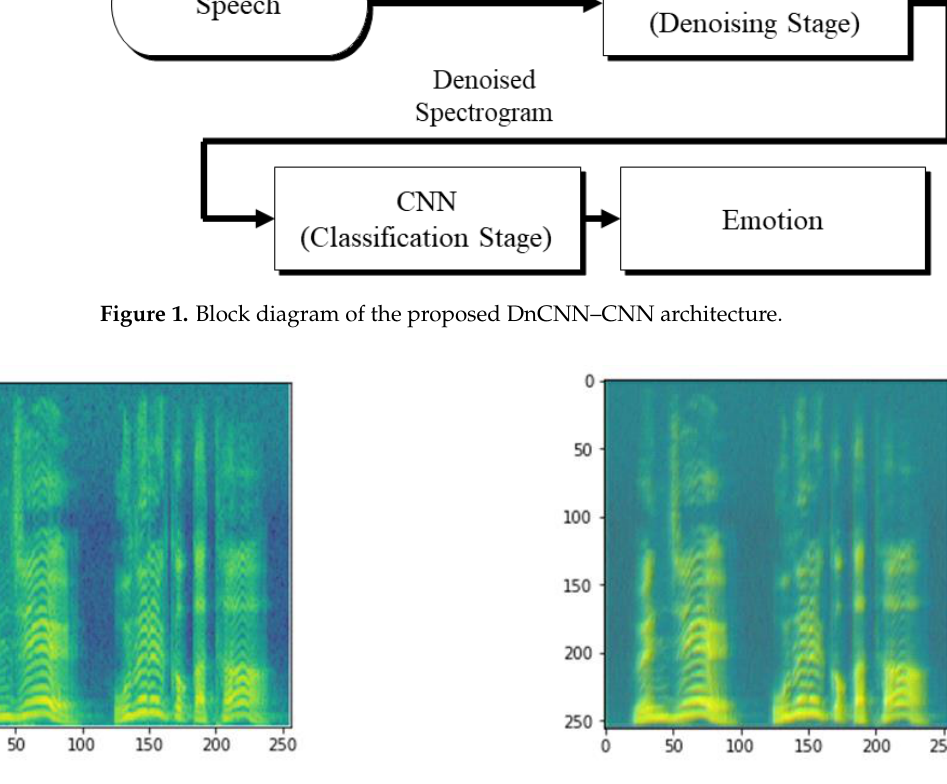
Figure 2. Sample spectrograms of an utterance in the Korean emotional speech database: ( a ) Original spectrogram; ( b ) Denoised spectrogram.